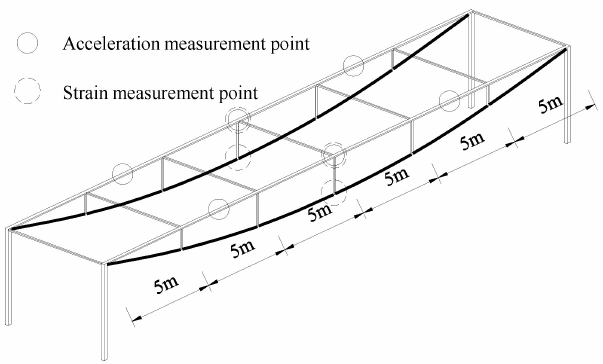
Figure 6. Schematic diagram of the 30 m span AERORail supported by 5